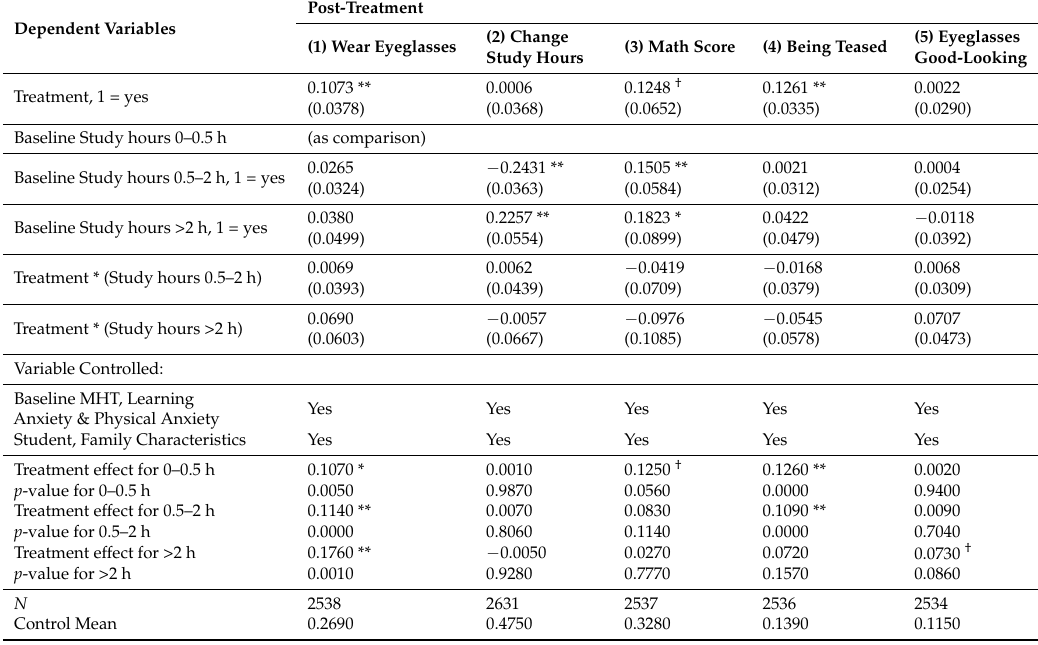
Table 4. Impact of Providing Fully Subsidized Eyeglasses on Secondary Outcomes by Daily After-class Study